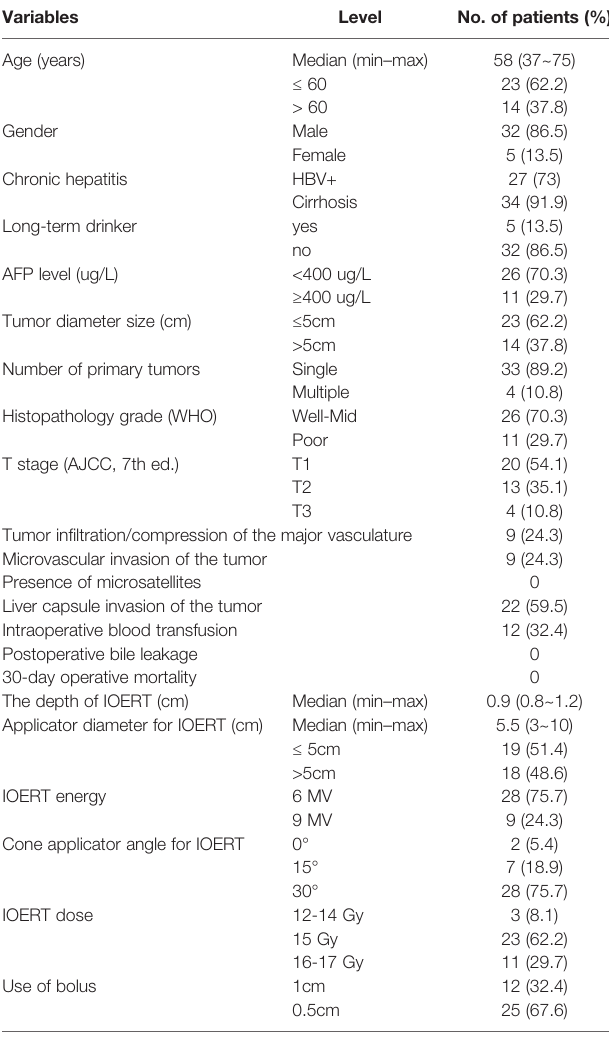
TABLE 1 | Demographic and clinicopathological features of the 37 patients with radical resection combined with IOERT.